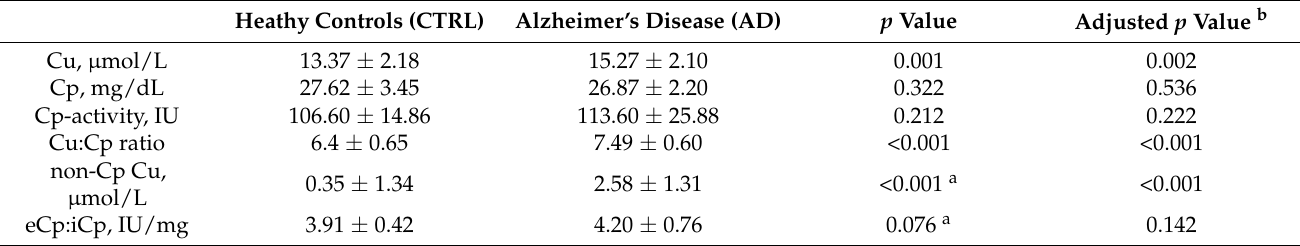
Table 2. Comparison of the Cu panel between CTRL and AD